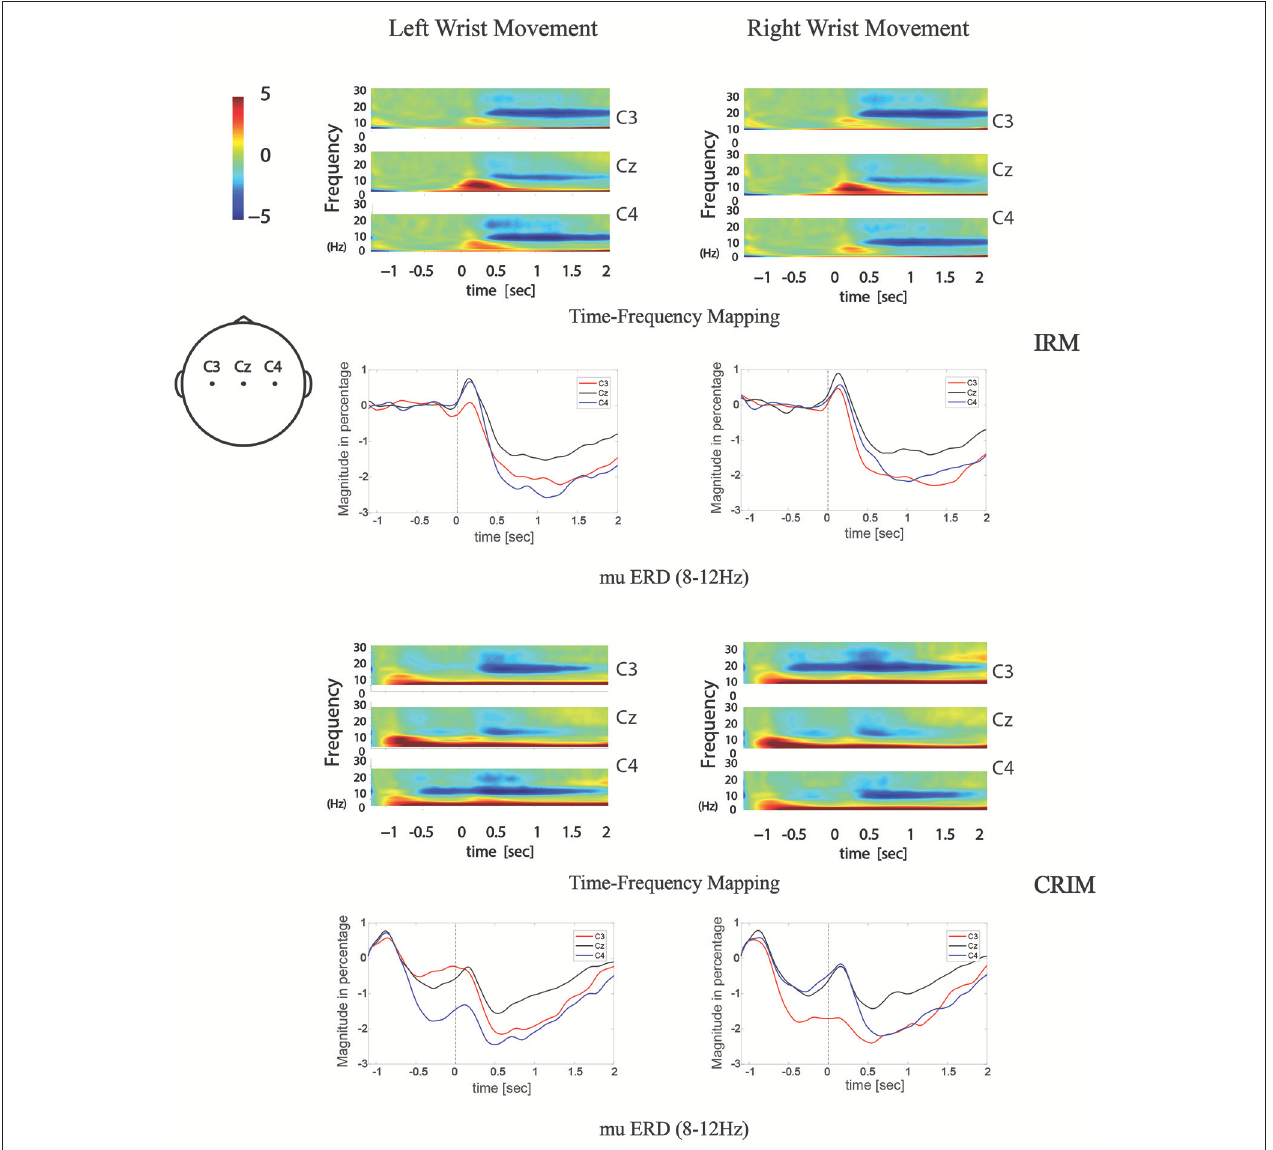
FIGURE 5 | Time-frequency mapping and mu ERD during movement tasks in both tests. Frequency data was transformed from grand average EEG data of all subjects. 8–12Hz frequency band data was abstracted from the time-frequency mapping and transformed into the mu ERD line graphs. significant differences found between Cz and the